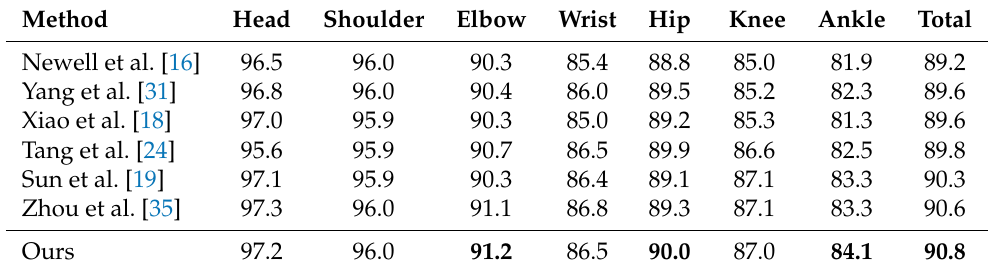
Figure 9. PCKh@0.5 score curves of our approach and HRNet on the MPII dataset. Table 2. Performance comparisons on the MPII validation set